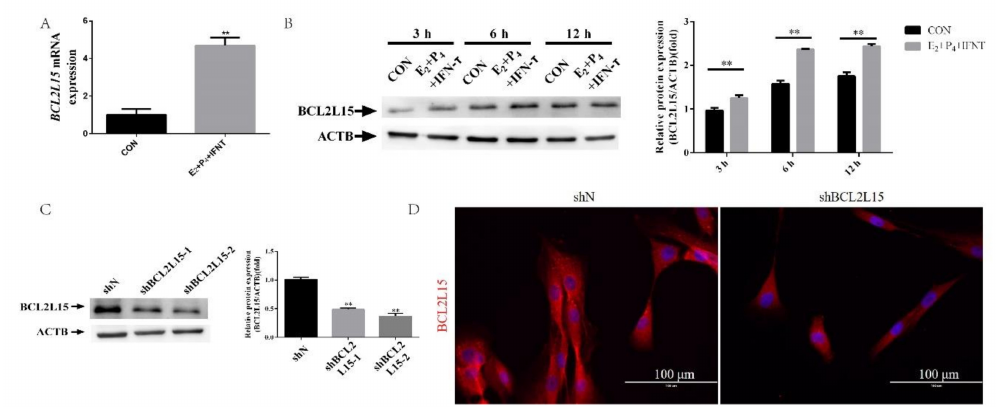
Figure 1. The expression of B-cell lymphoma 2 (Bcl-2)-like protein 15 (BCL2L15) in endometrial epithelial cells (EECs) under progesterone (P 4 ), estradiol (E 2 ), and interferon-tau (IFN- τ )